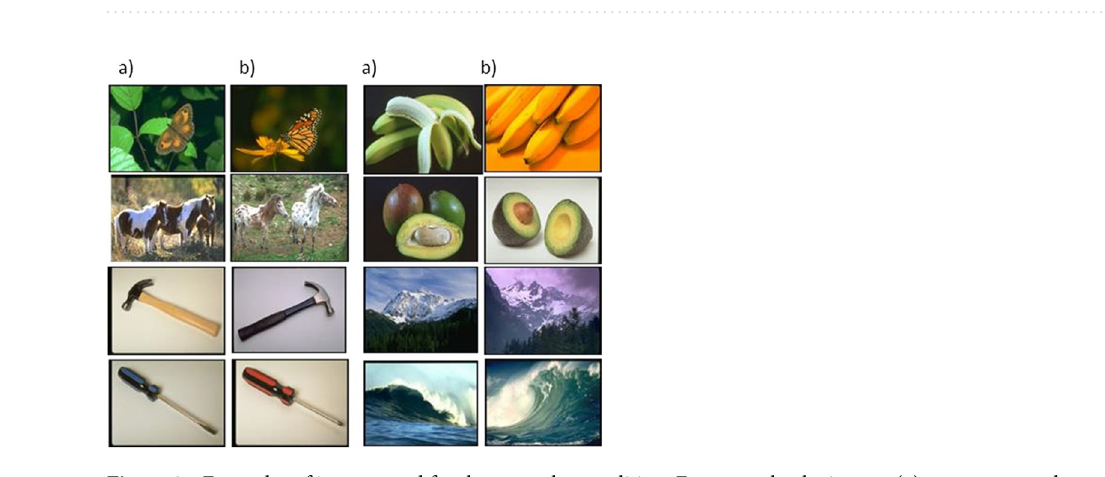
Figure 1. Examples of meaningful images (top three rows) and meaningless images (bottom three rows) used in the experiment. The images came from the CerCo lab’s collection of images.